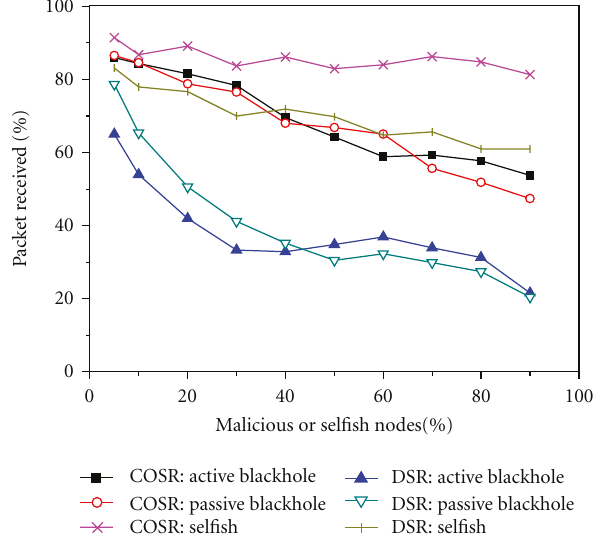
Figure 4: COSR against